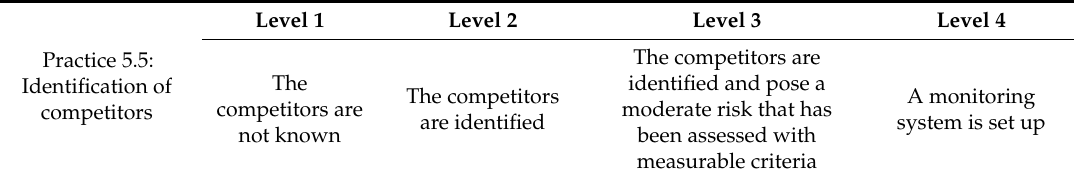
(Table 3: example). It was decided to work with four levels by analogy to the innovative companies’ classification in four categories proposed by (Godet 2007). Table 3. Maturity grid associated with the practice: identification of